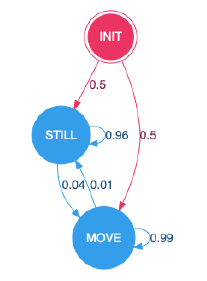
Figure 6 . Graph of transition probabilities between the states still and move